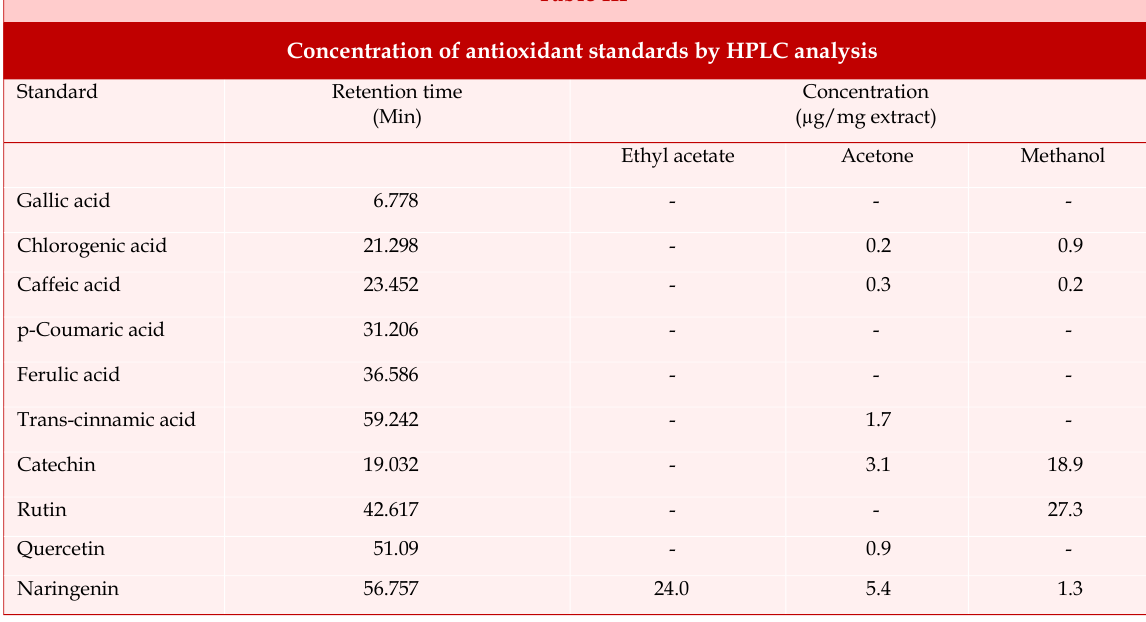
Concentration of antioxidant standards by HPLC